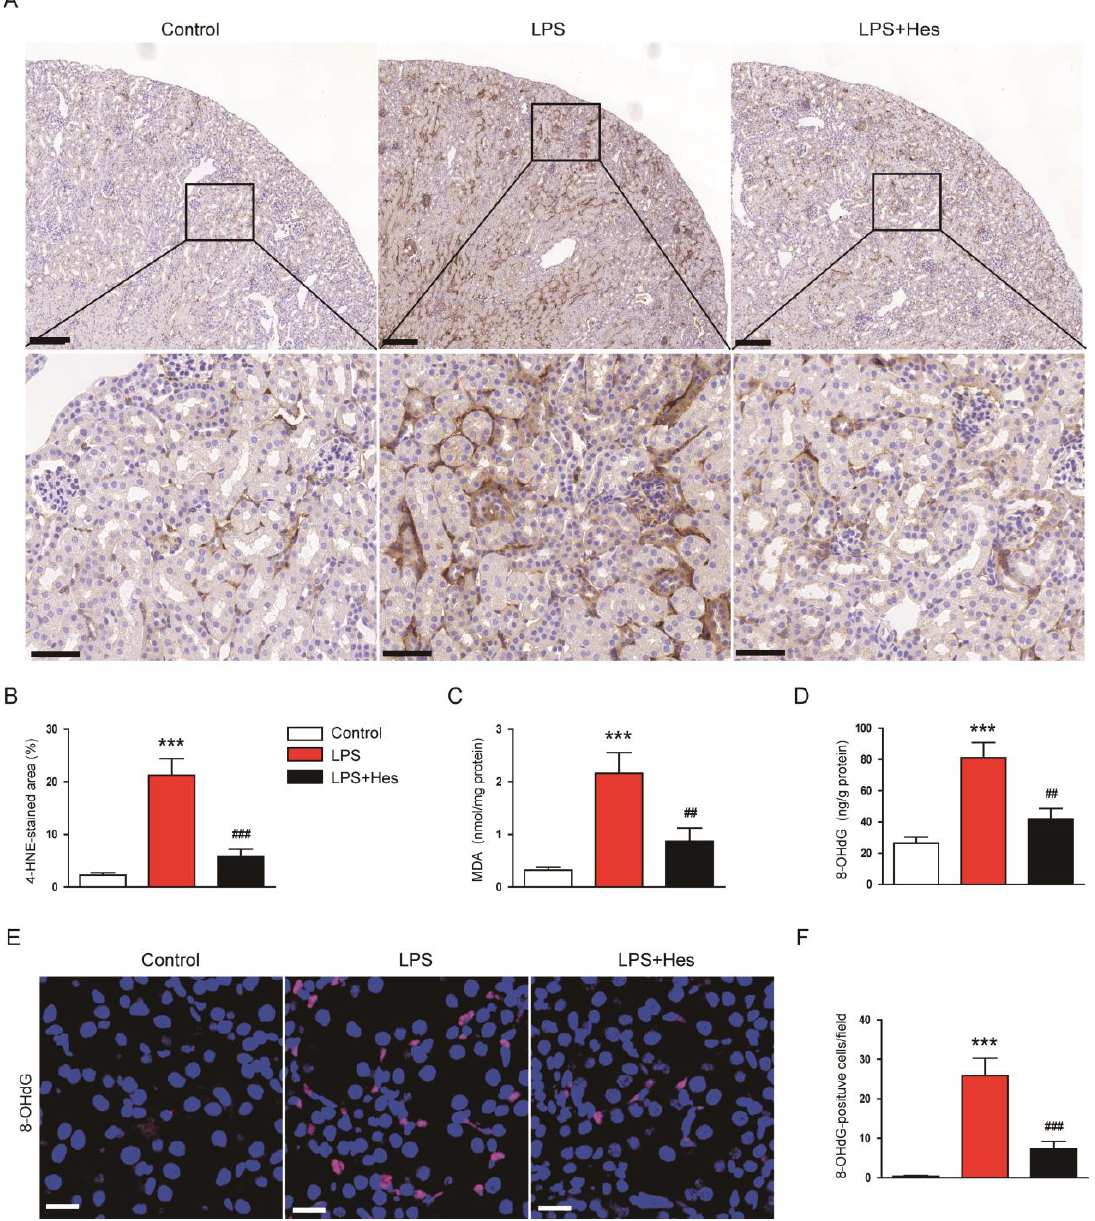
Figure 4. Hesperetin inhibited LPS - induced oxidative stress. ( A ) IHC staining for 4 - hydroxynonenal (4 - HNE). Scale bars: 150 μm (upper panel) and 50 μm (lower panel). ( B ) Per- (4-HNE). Scale bars: 150 µ m (upper panel) and 50 µ m (lower panel). ( B ) Percentage of the 4-HNE-stained centage of the 4 - HNE - stained area per field. ( C ) Renal malondialdehyde (MDA) levels. ( D ) Renal area per field. ( C ) Renal malondialdehyde (MDA) levels. ( D ) Renal 8-hydroxy-2 (cid:48) -deoxyguanosine 8 - hydroxy - 2′ - deoxyguanosine (8 - OHdG) levels. ( E ) IF staining for 8 - OHdG. Scale bar: 20 μm. ( F ) Number of 8 - OHdG - positive cells per field. n = 8 per group. *** p < 0.001 vs. Control. ## p < 0.01 and (8-OHdG) levels. ( E ) IF staining for 8-OHdG. Scale bar: 20 µ m. ( F ) Number of 8-OHdG-positive cells ### p < 0.001 vs. LPS. per field. n = 8 per group. *** p < 0.001 vs. Control. ## p < 0.01 and ### p < 0.001 vs.